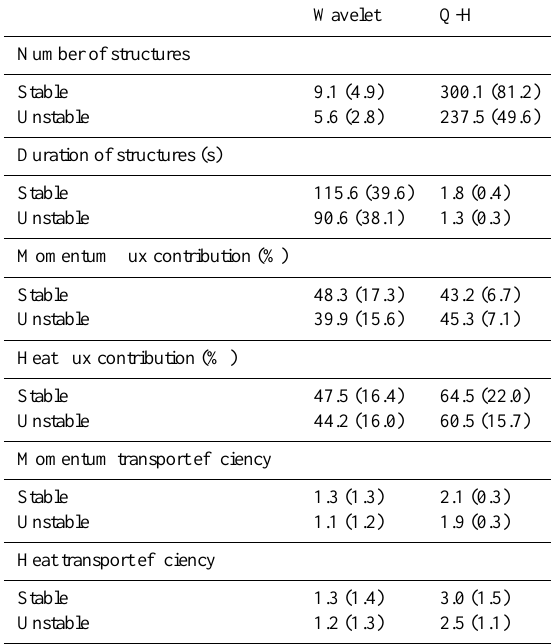
Table 1. Statistics of coherent structure detection for the CAB- INEX campaign, indicating the distribution function median (with standard deviation in